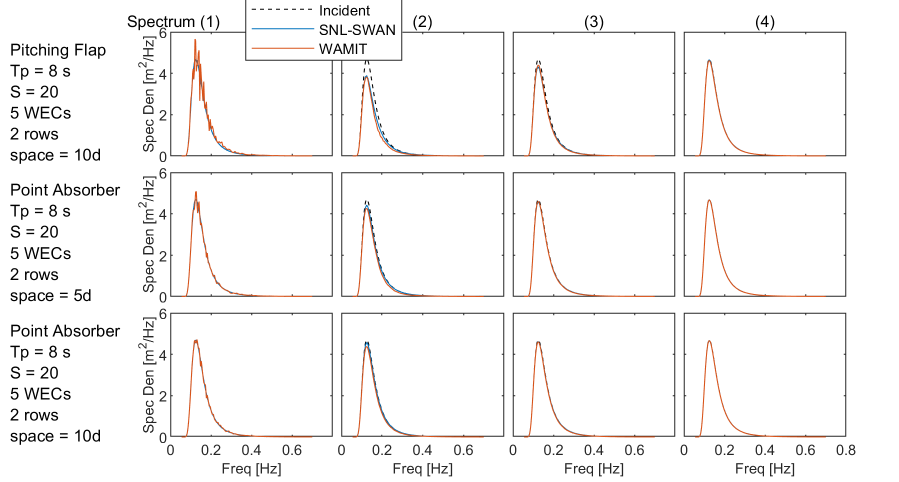
Figure 10. WEC array spectra: plots of the omnidirectional wave spectra at the four points marked in the WAMIT wave